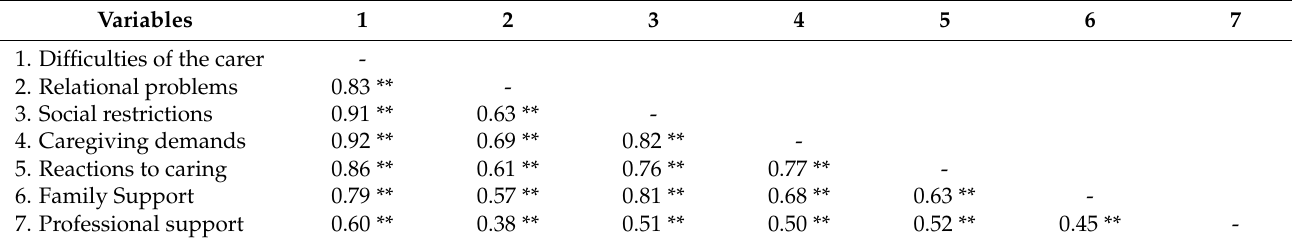
Table 5. Study of the association between the dimensions of caregiver difficulties.